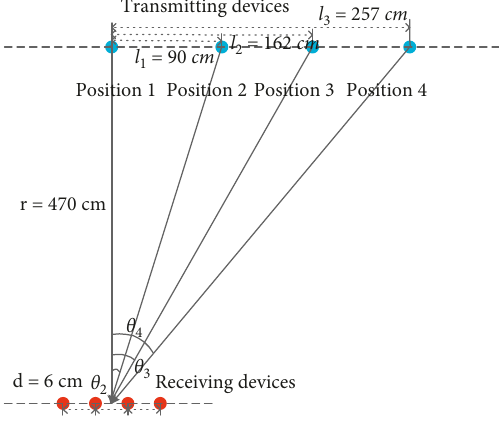
Figure 14: DOA estimation